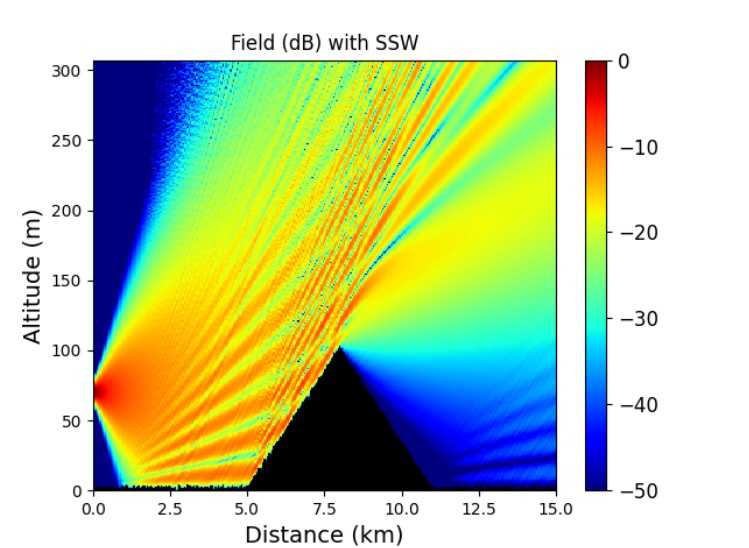
Figure 7. Propagation over a rough terrain obtained with one-way